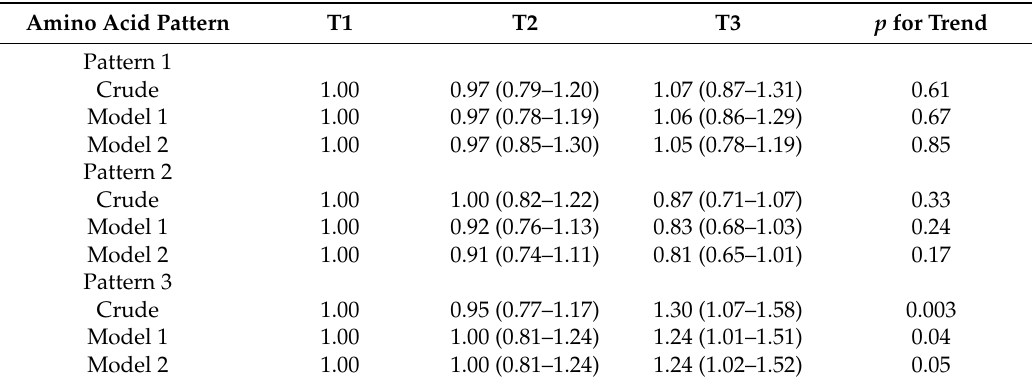
Table 3. The hazard ratio (95% confidence interval (CI)) of pre-diabetes across tertile categories of amino acid patterns